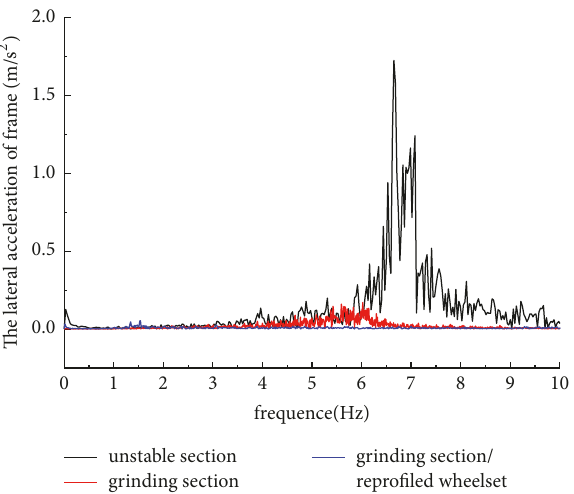
Figure 8: The spectrum map of lateral acceleration of bogie frame.